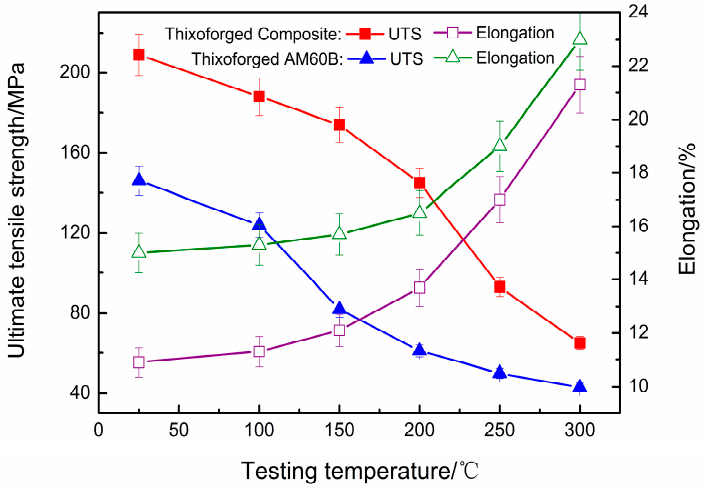
Figure 2. The variations in tensile properties of the thixoforged composite and AM60B with testing